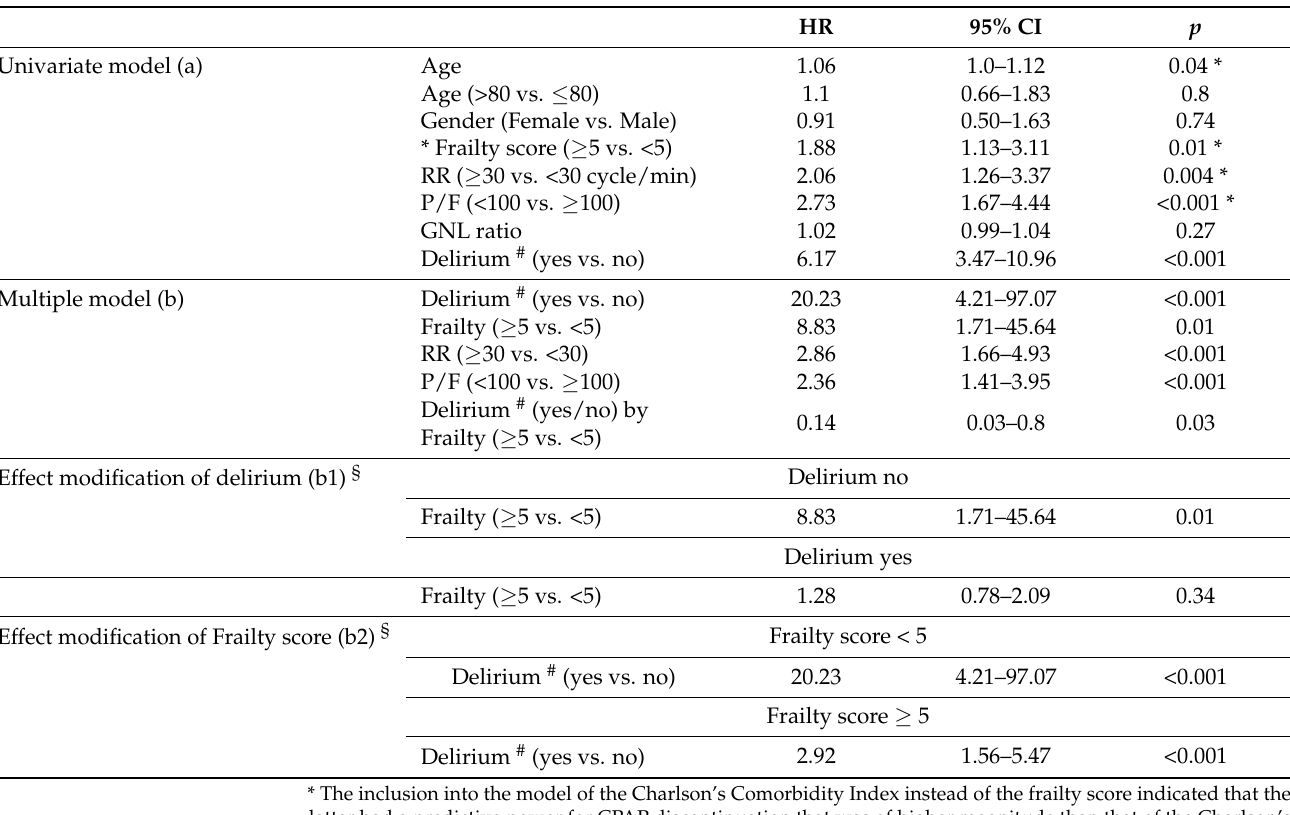
Table 3. Univariate (panel a) and multiple (panel b) Cox analyses of death by baseline characteristics and delirium as a time-varying covariate.